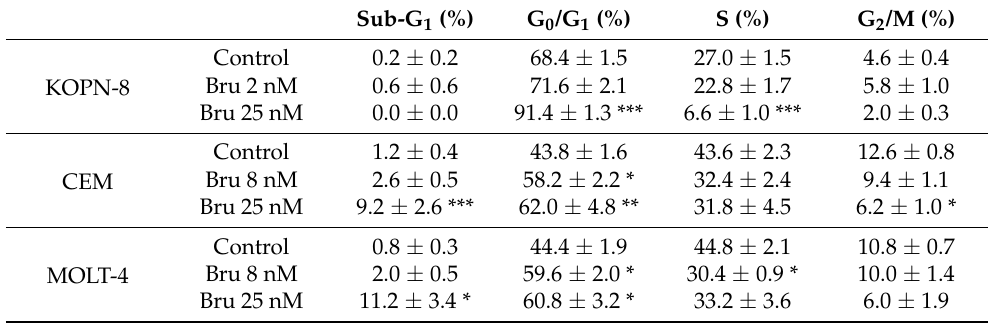
Data are expressed as percentage of cells in G 0 /G 1 phase, S phase, G 2 /M phase, and apoptotic peak and represent mean ± SEM obtained from at least 3 independent experiments. * p < 0.05, ** p < 0.01, *** p < 0.001 comparing with untreated cell (control). Bru: Brusatol.